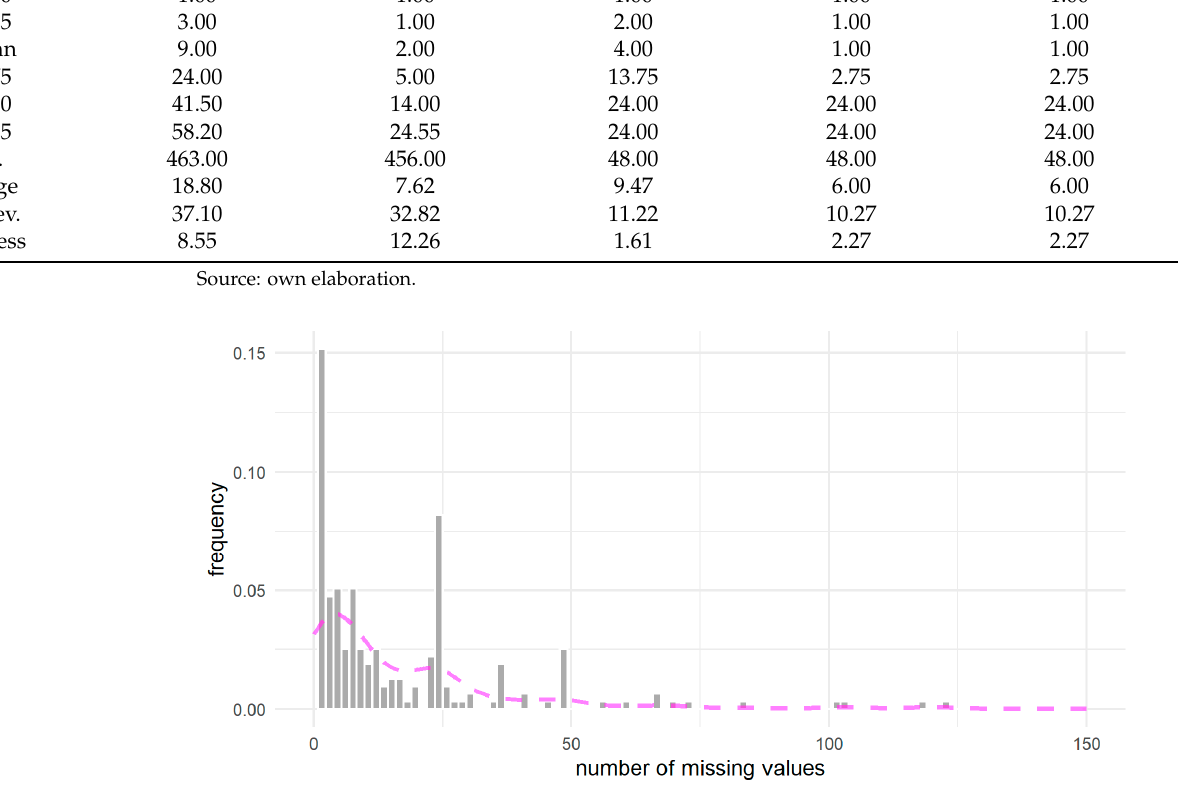
Figure 1. Distribution of the number of missing values. Source: own elaboration.